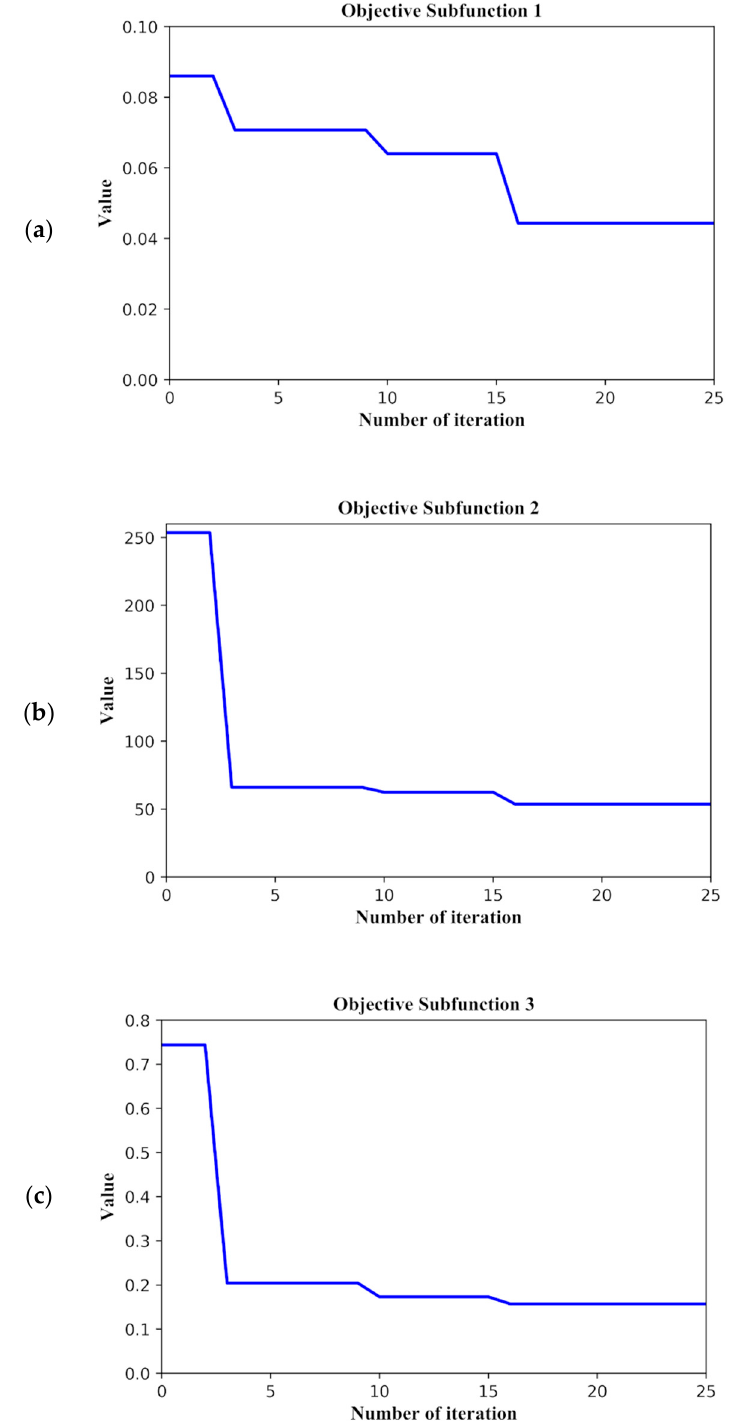
Figure 11. Evolution in the values obtained, for the best particle of each iteration, in case 1 applied to cluster 1, in the objective subfunctions of ( a ) congestion characteristic values, ( b ) time scenario characteristic values, and ( c ) inclination angle.